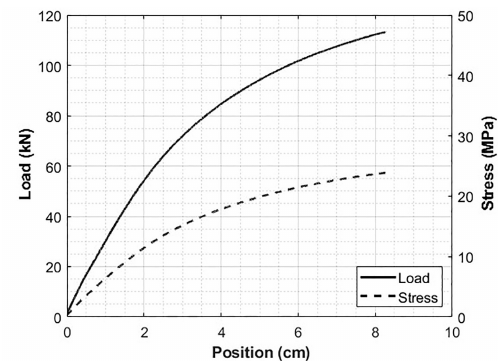
Figure 9. Example load-deflection curve of a crosstie from a four-point bend